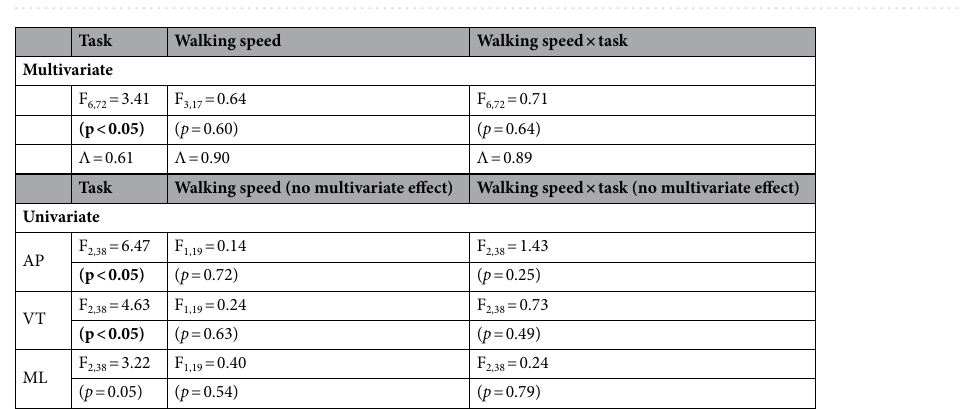
Figure 2. Mean sample entropy (SaEn) values when walking at self-selected normal (NWS) and fast walking speed (FWS) while texting on a mobile phone, talking, or performing no concurrent task (walking only). Black bars = anteroposterior axis, White bars = vertical axis, Grey bars = mediolateral axis. ‘*’ denotes a statistically significant effect of walking speed instruction. ‘t’ denotes a statistically significant effect of task.